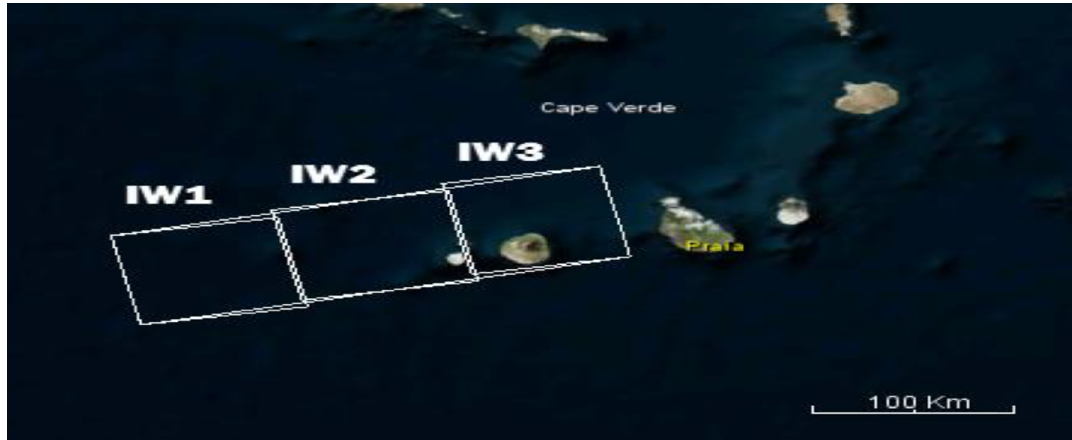
Figure 3. Sub-swaths Interferometric Wide (IW)1, IW2, and IW3 [56] .